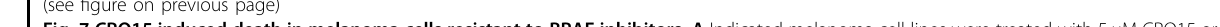
Fig. 7 CRO15 induced death in melanoma cells resistant to BRAF inhibitors. A Indicated melanoma cell lines were treated with 5 μ M CRO15 or 5 μ M PLX4032. After 48 h, cell viability was determined by Trypan blue exclusion method. The results are expressed as percentages of the corresponding control and data given as the means ± SEM of three independent experiments performed in triplicate. * p < 0.05; ** p < 0.01; *** p < 0.001. B A375-resistant cells were treated with 5 μ M CRO15 for the indicated durations. Lysates were analyzed by western blotting with the indicated antibodies. One representative experiment of three is shown. C Immuno fl uorescence images of A375-resistant melanoma cells treated with 5 μ M CRO15 or 400 nM rapamycin for 6 h or DMSO control. LC3B was labeled with antibody (green), and the nuclei were visualized with DAPI (blue). D A375-resistant melanoma cells were treated for 24 h with 5 μ M of CRO15 or PLX4032 for 24 h or with 1 μ M staurosporine for 6 h. Cells were analyzed in fl ow cytometry with a speci fi c antibody directed Annexin V (conjugated with ALEXA) or Caspase 3 active protein (conjugated with FITC). * p < 0.05; ** p < 0.01; *** p < 0.001. E Female immune-de fi cient BALB/c nu/nu (nude) mice were inoculated subcutaneously with 1.0 × 10 6 A375-resistant cells. After 7 days, mice ( n = 6 in each group) were treated with CRO15 (0.7 mg/mouse/day), PLX4032 (0.7 mg/mouse/day) or vehicle (Labra fi l). Tumor growth curves were determined by measuring the tumor volume. The bars indicate the mean ± SEM. * p < 0.05; ** p < 0.01. F Tumor weight of A375- resistant xenograft after mouse euthanasia. The bars indicate the mean ± SEM * p < 0.05; ** p <